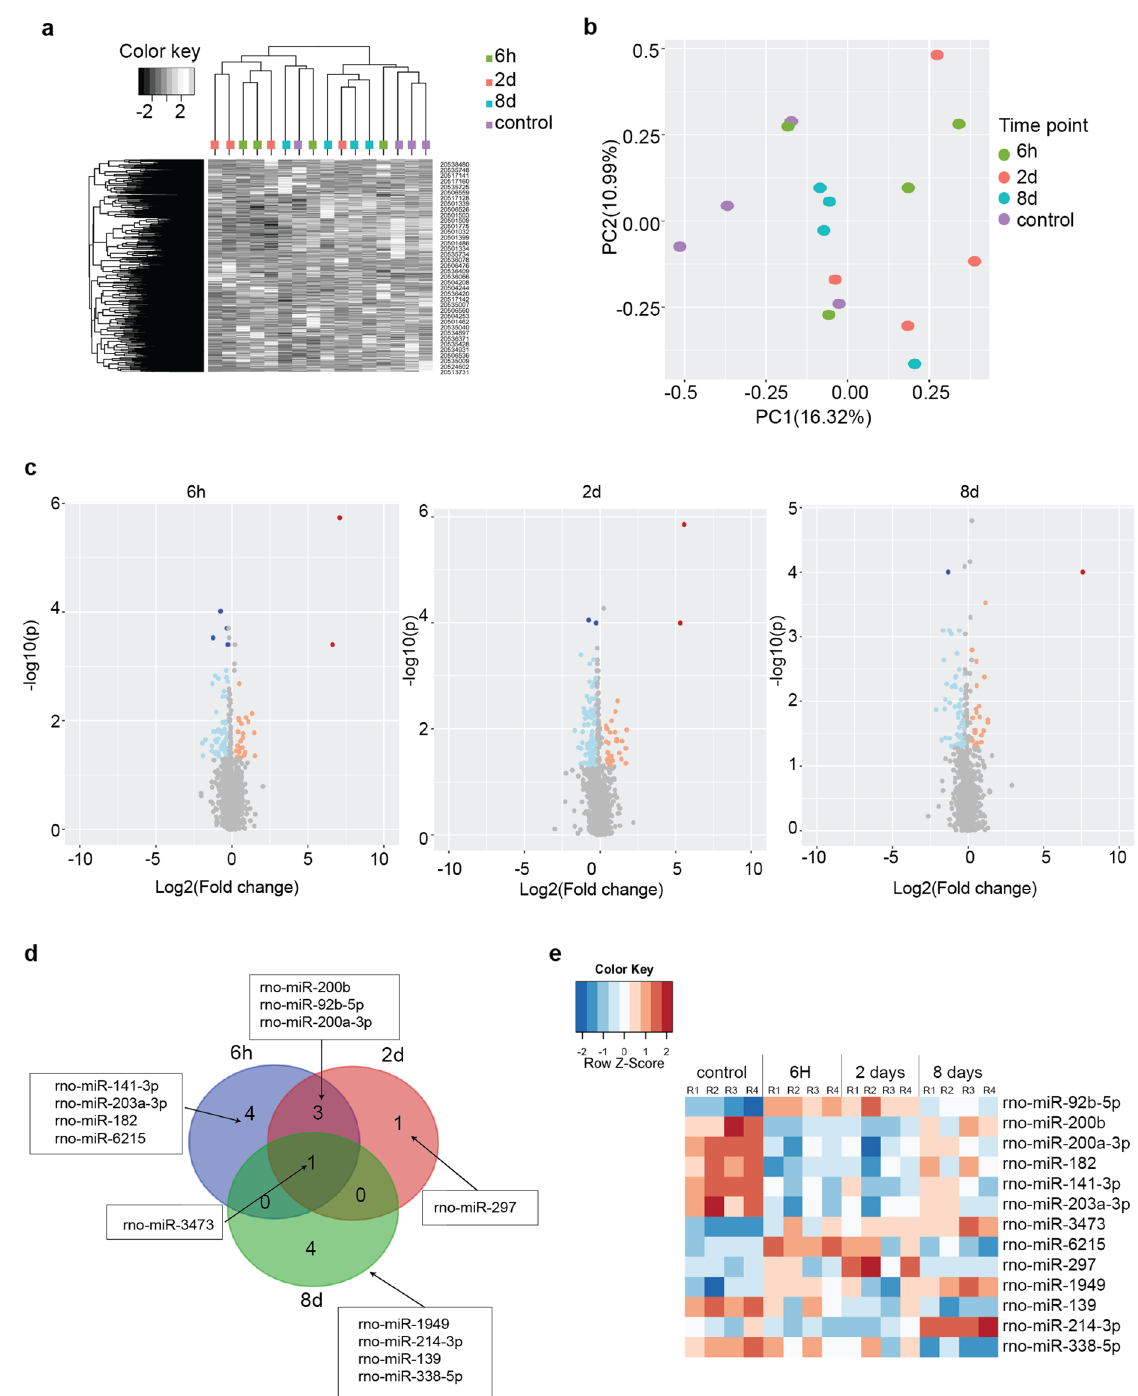
Figure 2. MicroRNA changes during bladder healing. ( a ). Heat map visualizing the expression levels of all genes for all replicates and conditions; the dendrograms indicate the results of hierarchical clustering. ( b ) PCA plot illustrating the microRNA expression landscape. ( c ) Volcano plots showing the statistical significance (p value) versus magnitude of change (fold change). Each point in the volcanos represents a microRNA transcript. Transcripts at the upper left and upper right corners are most likely to be differentially expressed. ( d ) Venn diagram illustrating the overlap in differentially expressed microRNA genes at 6 h, 2 days and 8 days post wounding. Thresholding was performed using a p value of 0,05 and FDR 0,05. e. Heat maps summarizing the expression of DE microRNAs across all the time points